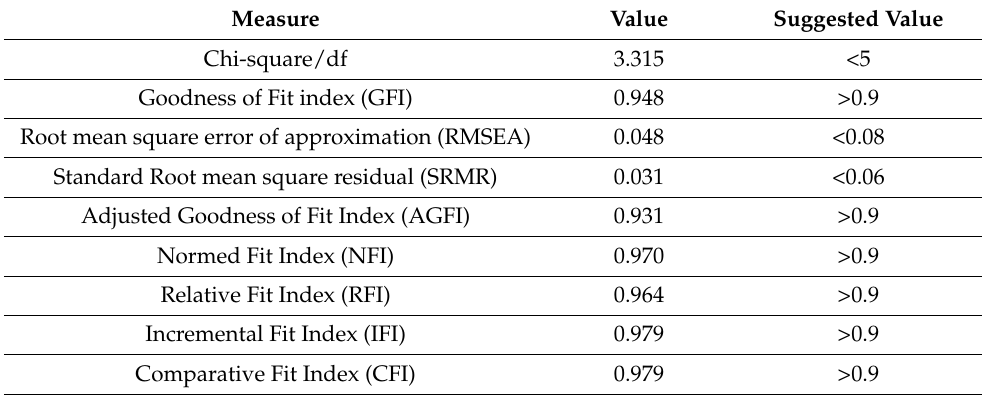
Table 2. Model Fit